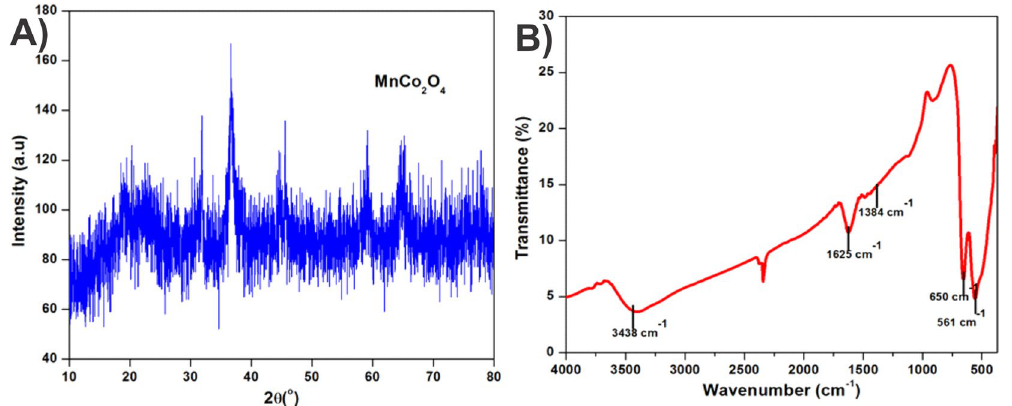
Figure 2. ( A ) XRD pattern ( B ) FTIR spectrum of porous MnCo 2 O 4 spinel